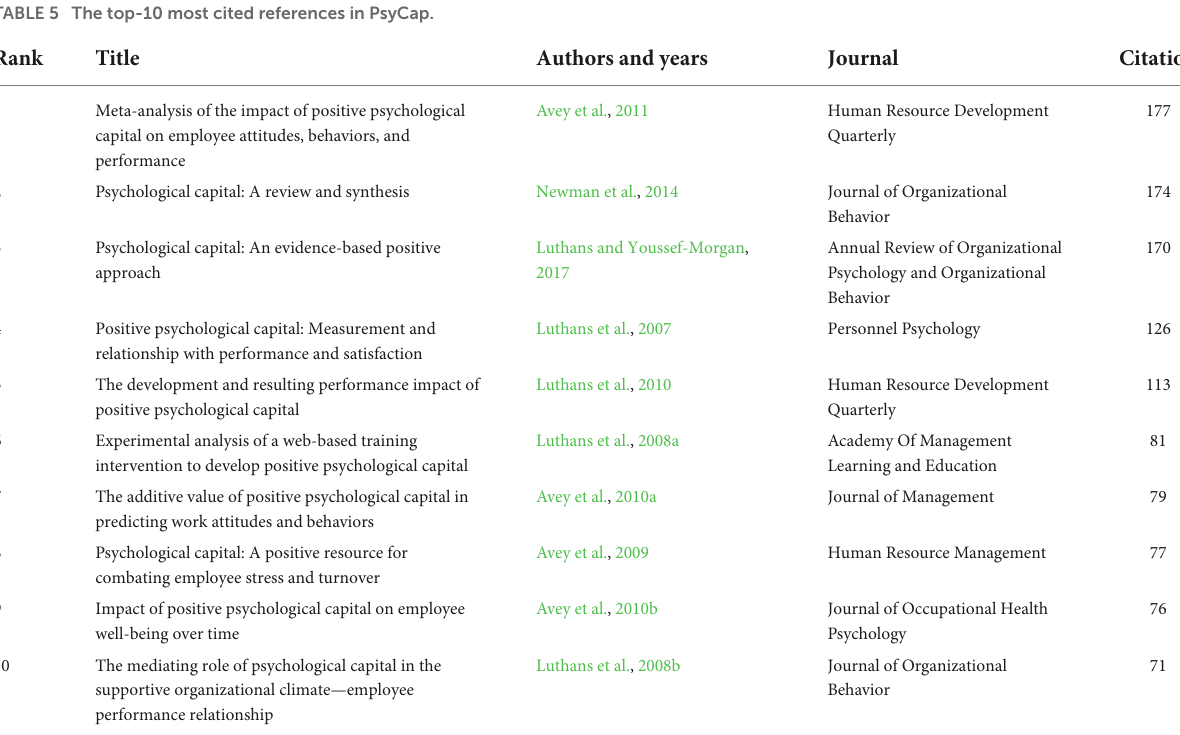
TABLE 5 The top-10 most cited references in